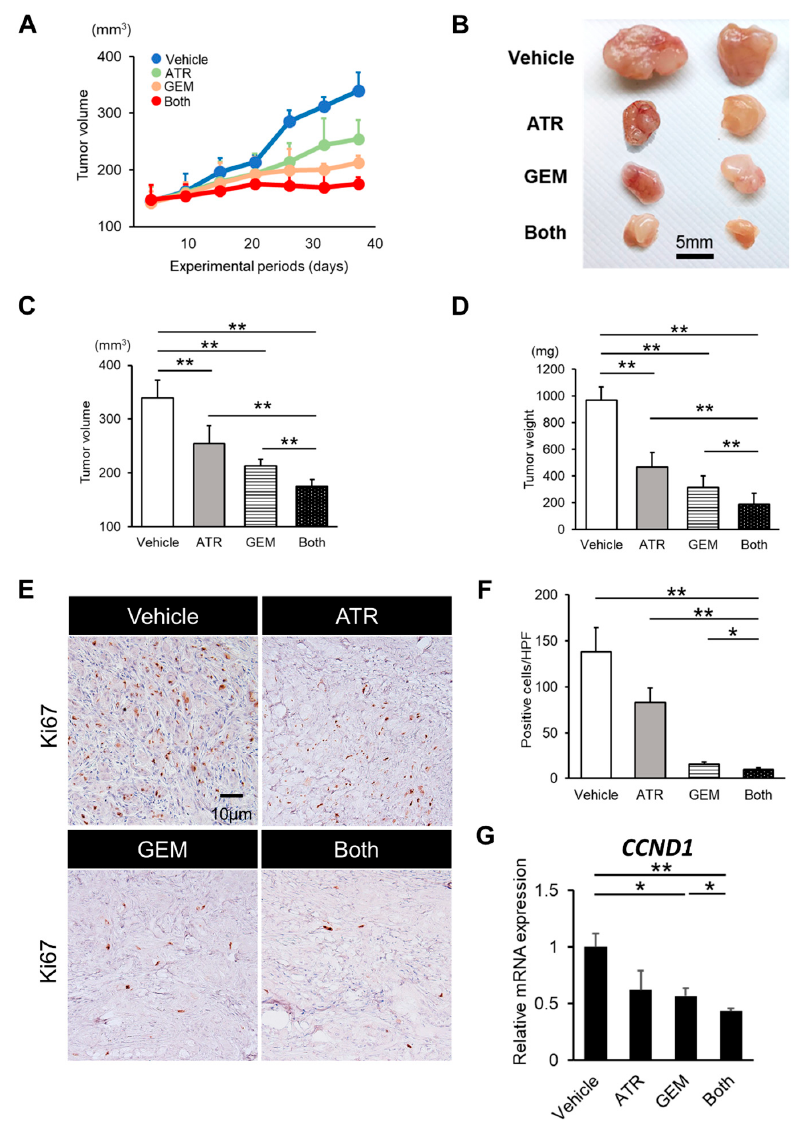
Figure 4. Gemcitabine plus atorvastatin suppressed HuCCT-1 cell-derived tumor growth and inhibited tumor cell proliferation in xenograft model. ( A ) HuCCT-1 cell-derived xenograft tumors grew progressively in vehicle-treated control mice, but they grew more slowly in mice treated with either atorvastatin (100 mg / kg / day) or gemcitabine (100 mg / kg / 3 days). ( B ) Representative photographs of resected subcutaneous tumors. ( C , D ) The mean tumor volumes ( C ) and weights ( D ) of mice treated with atorvastatin, gemcitabine, or both. ATR, atorvastatin-treated mice. GEM, gemcitabine-treated mice. Both, mice treated with both atorvastatin and gemcitabine. Data are presented as the mean ± SD ( n = 10). * p < 0.05; ** p < 0.01. ( E ) Representative pictures of HuCCT-1 cell-grafted subcutaneous tumors stained for Ki67. ( F ) Quantification of Ki67-positive cells. The number of immunopositive cells in high-power fields was counted. ( G ) Relative mRNA levels of CCND1 in HuCCT-1 cell-derived xenograft tumors. The mRNA expression levels were measured using quantitative real-time PCR, and glyceraldehyde-3-phosphate dehydrogenase was used as an internal control. Quantitative values are indicated as ratios of the values of the vehicle-treated group.